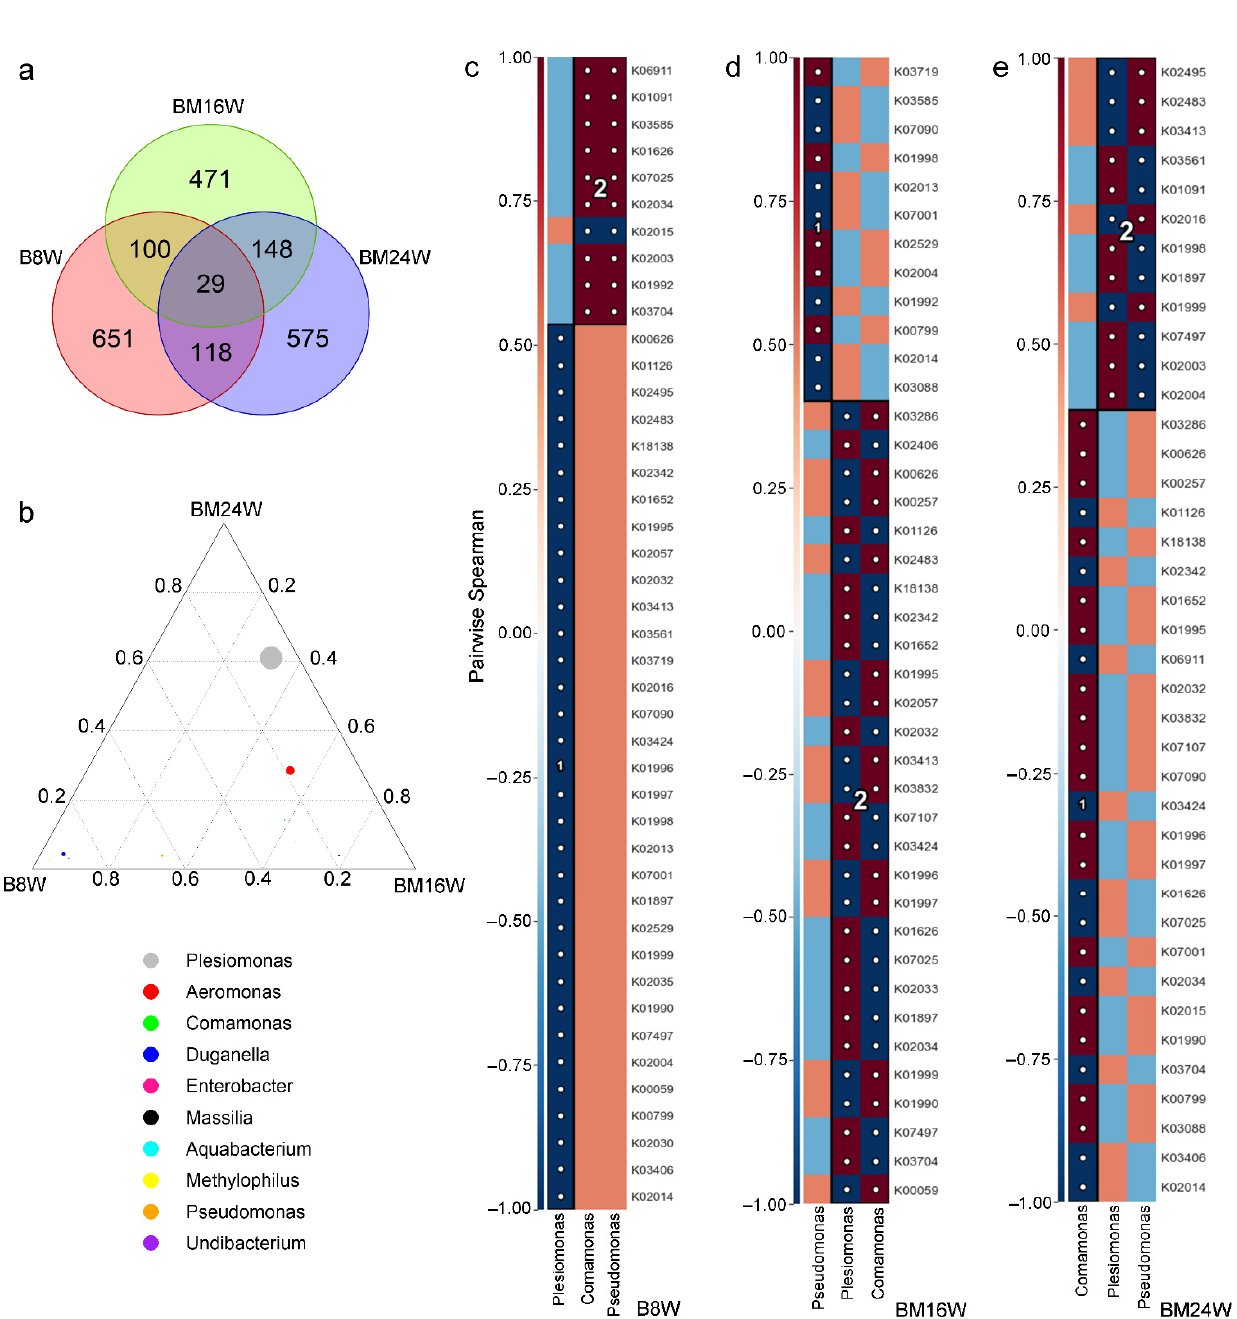
Figure 7. Association between Siamese fighting fish gut microbiota and predicted function. ( a ) Numbers of shared and unique associations between young and male adult samples were identified by hierarchical all-against-all association (HAIIA). ( b ) A ternary plot of the top 10 genera across groups. The size of circles is proportional to the relative abundance. The closer the circle is to the vertices, the more abundant a certain genus is in a sample. ( c – e ) Heatmaps representing a significant relationship between the dominant Siamese fighting fish gut microbiota and top 50 K numbers in terms of relative abundance ( q < 0.0001) in the B8W, BM16W, and BM24W groups (respectively). B8W, 8-week-old Siamese fighting fish; BM16W, 16-week-old male Siamese fighting fish; BM24W, 24-week-old male Siamese fighting fish.